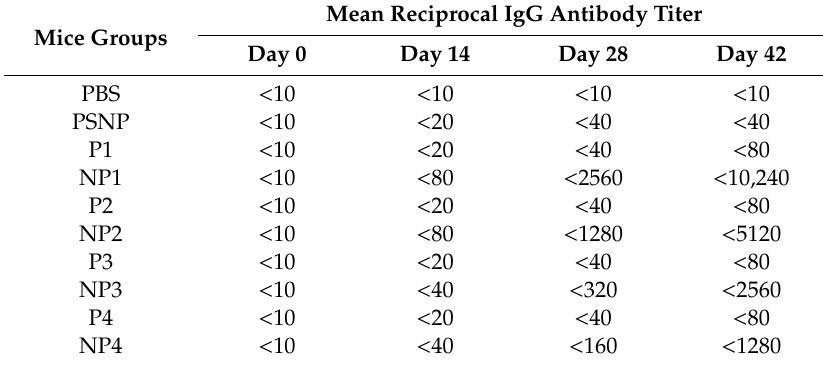
Table 2. Time course of IgG antibody production elicited by the multi-epitope constructs containing the respective peptides in immunized